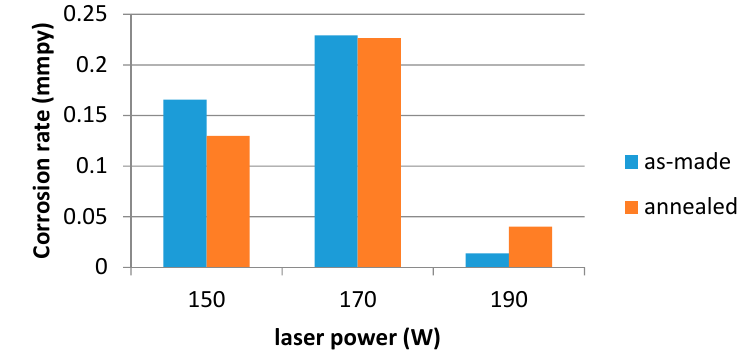
Figure 10. Corrosion rate after 144 h exposure in the test solution.